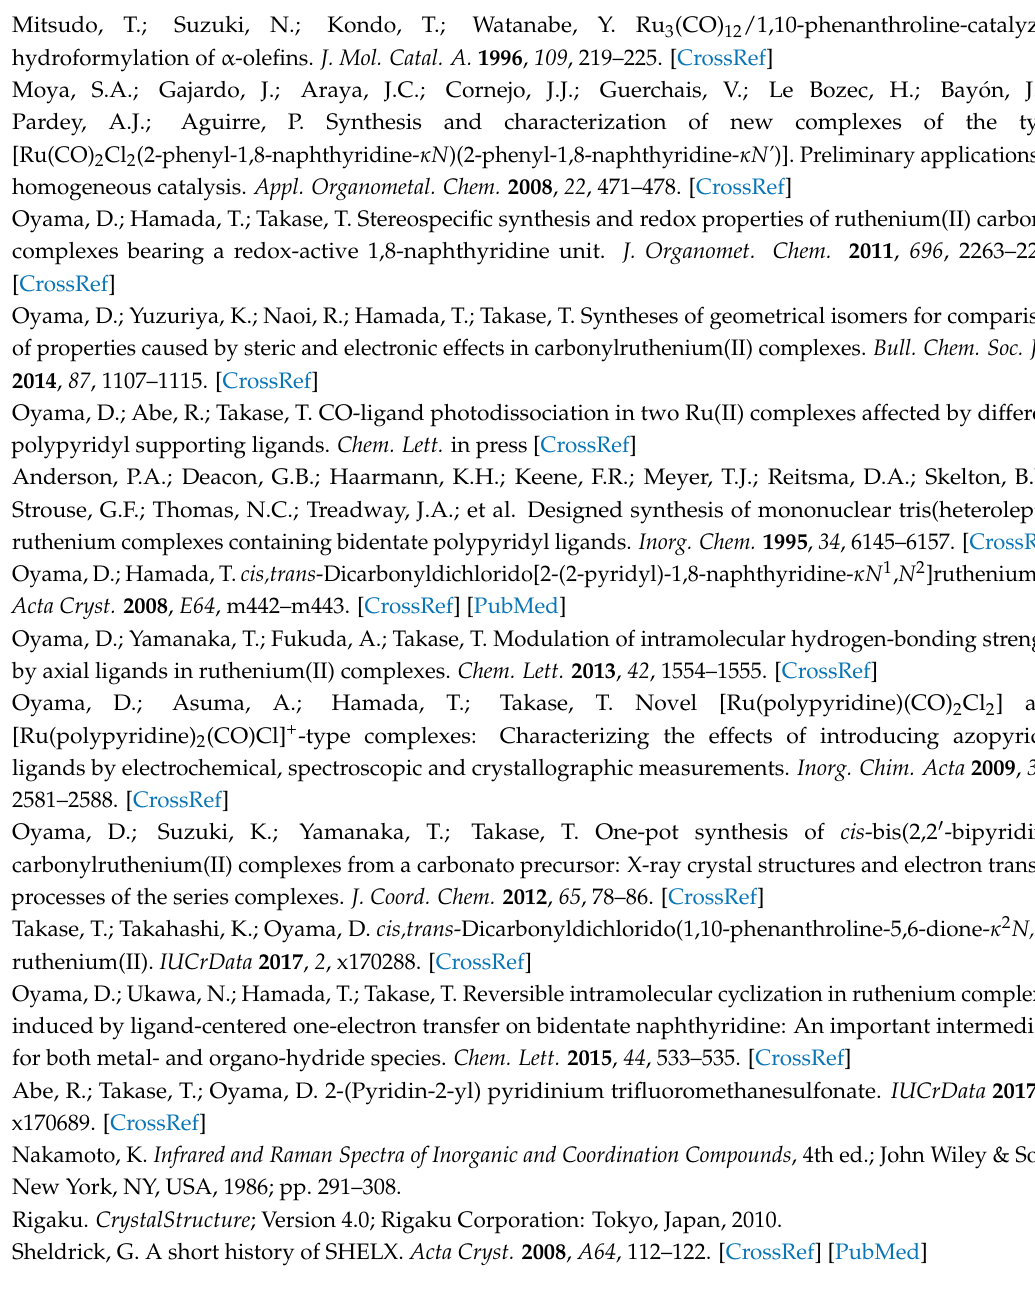
Figure S1: IR spectrum of the title compound (KBr pellet) and Table S1: Comparison between the experimental and DFT-calculated IR peaks for ν